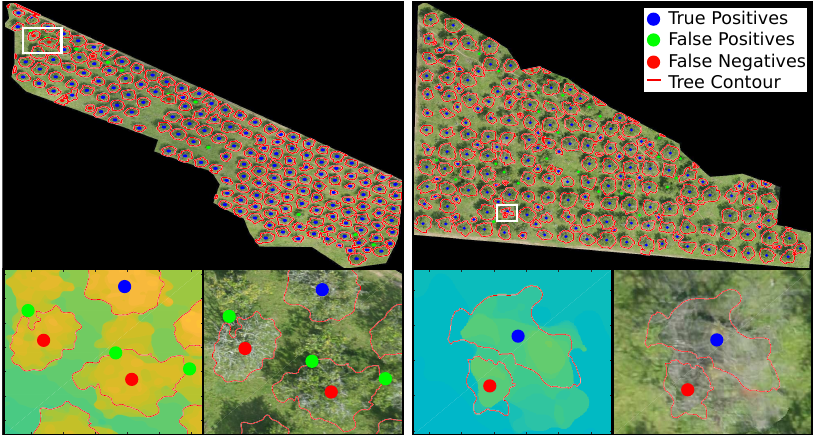
Figure 6. Results obtained by Farm 2 data set using SEMAX* approach, where blue, red, and green dots represent true positives, false negatives, and false positives,